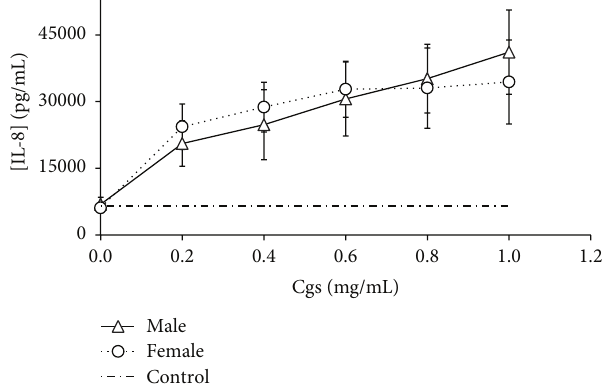
Figure 2: Increase in IL-6 concentration (pg/mL) in culture medium after the 24-hour incubation of PBMCs from male and female healthy subjects with Cgs isolated from the blood of male and female SCZ patients, respectively.